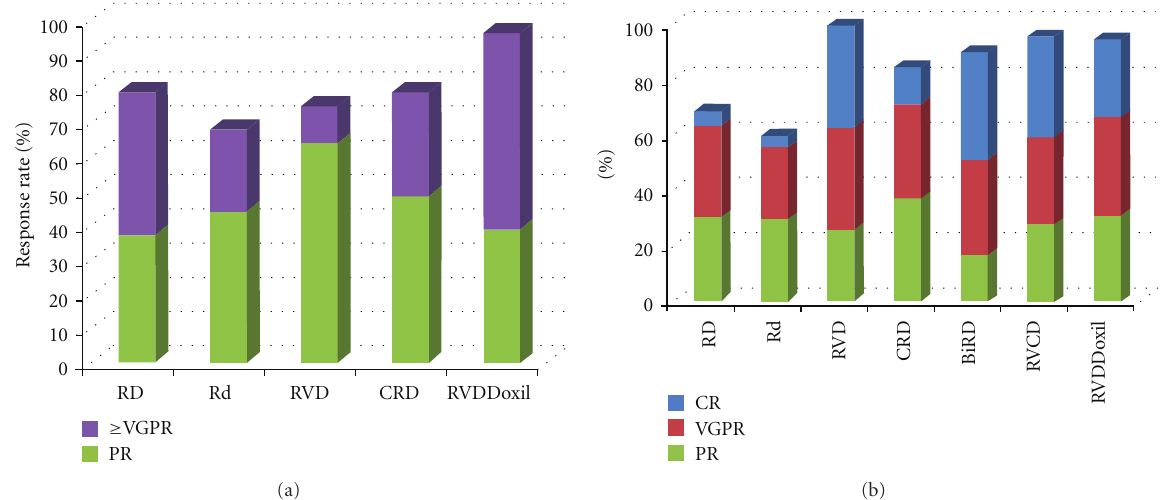
Figure 1: Reported response rates for lenalidomide-based induction regimens for MM. Rates depicted are those that could be ascertained either directly using reported data or as calculated using reported data. (a) Response rates after four cycles of therapy. Deeper response rates are not displayed due to inconsistent reporting in referenced sources. (b) Best response reached on study. Rates after four cycles could be envisioned as a measure of expected response pre-ASCT, whereas best response rate may represent a regimen’s maximum potential, but only after more cycles than a patient would usually be administered as pre-ASCT induction. Data was gleaned from the following sources: